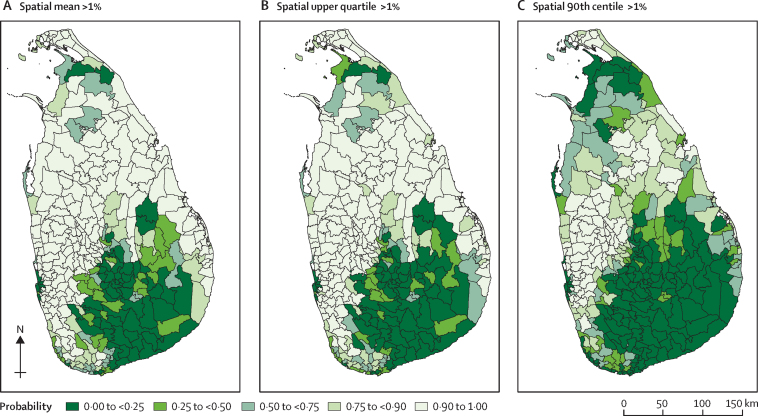
Probability of not exceeding soil-transmitted helminth prevalence of 1% at Medical Officer of Health levelProbability of not exceeding soil-transmitted helminth prevalence of 1% for spatial mean (A), spatial upper quartile (B), and spatial 90th centile (C).